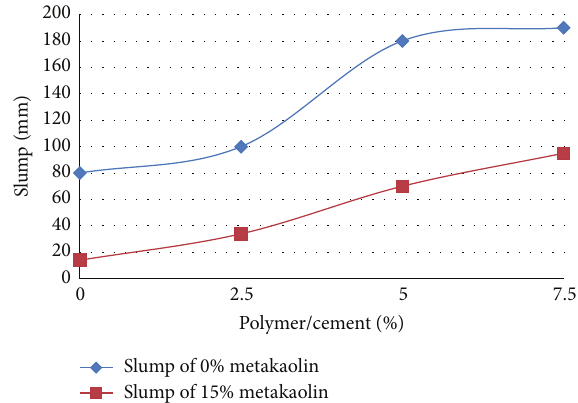
Figure 7: The compressive strength at different polymer contents with 0% m/c and w/c = 45%.